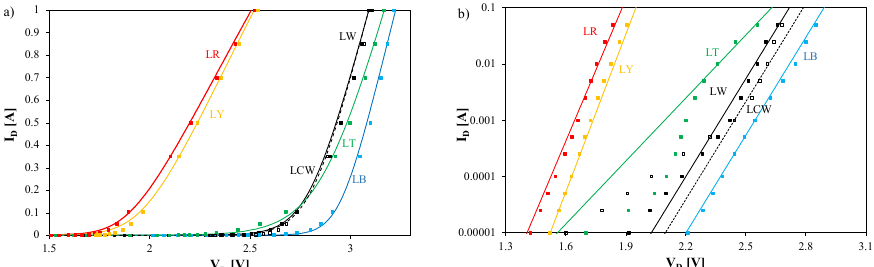
Table 2. Estimated values of the parameters of the electrical models for the investigated LEDs.